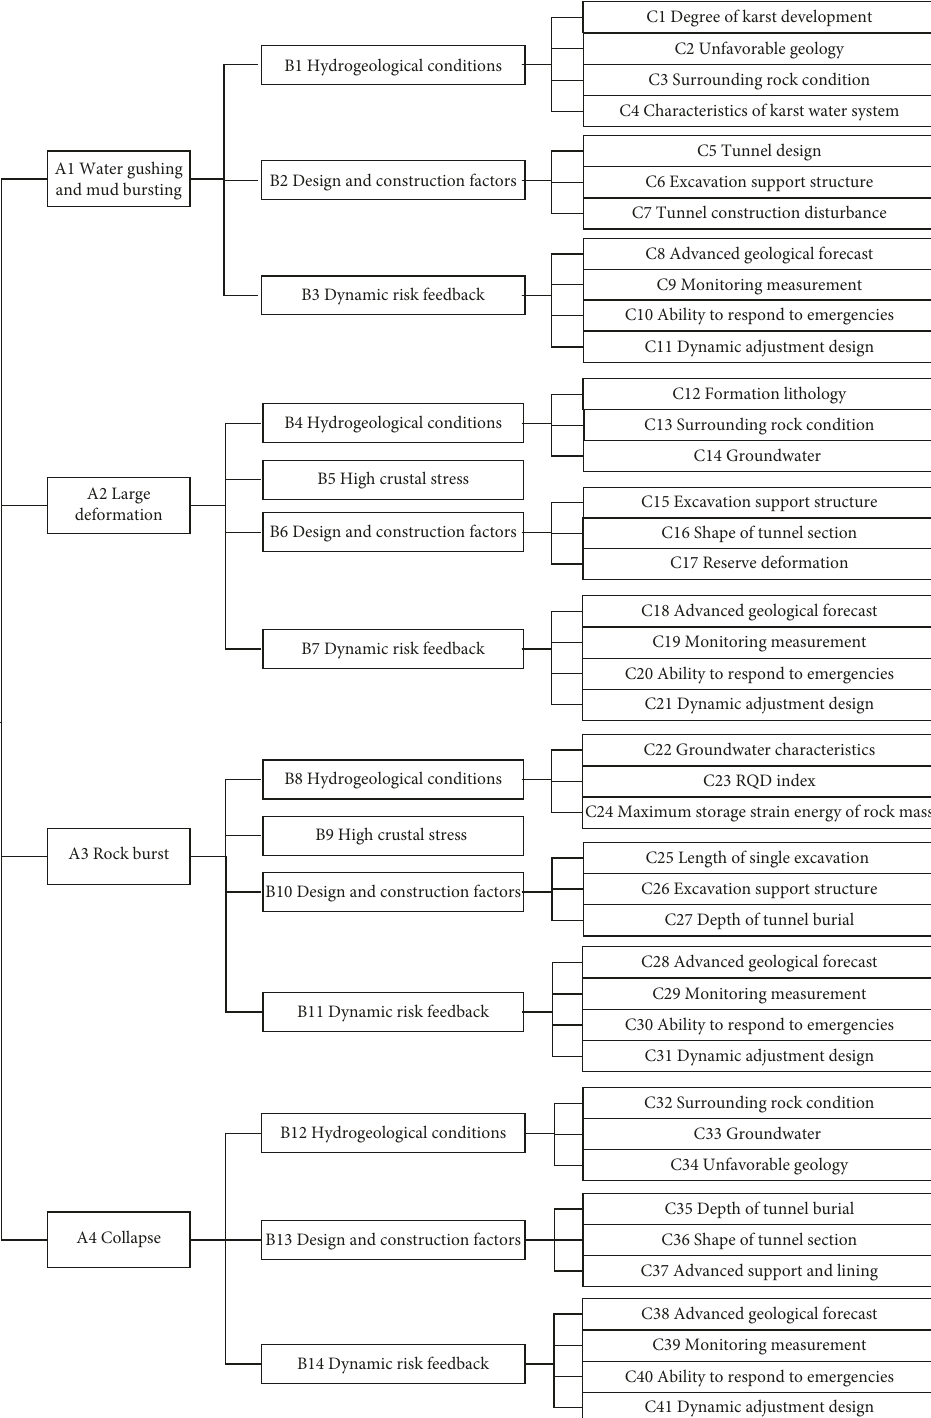
Figure 2: Disaster risk evaluation index of deep-buried and superlong highway